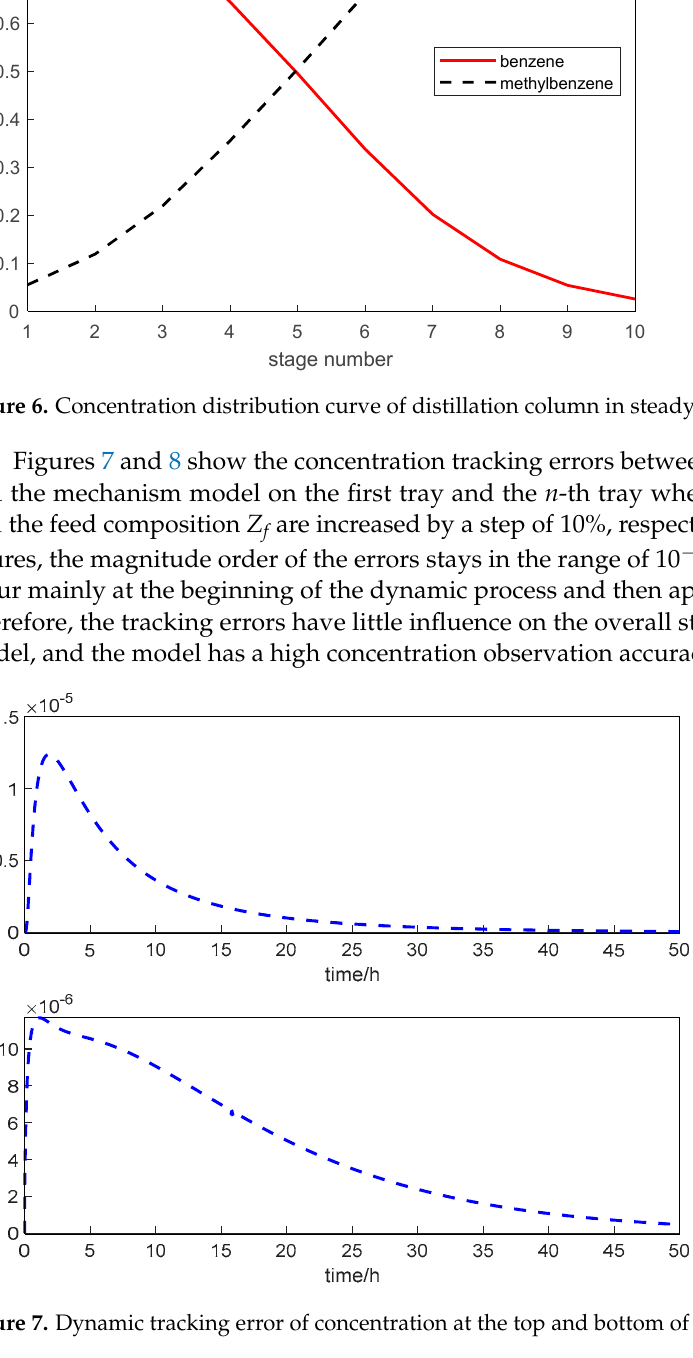
Figure 7. Dynamic tracking error of concentration at the top and bottom of the column when F +10%.